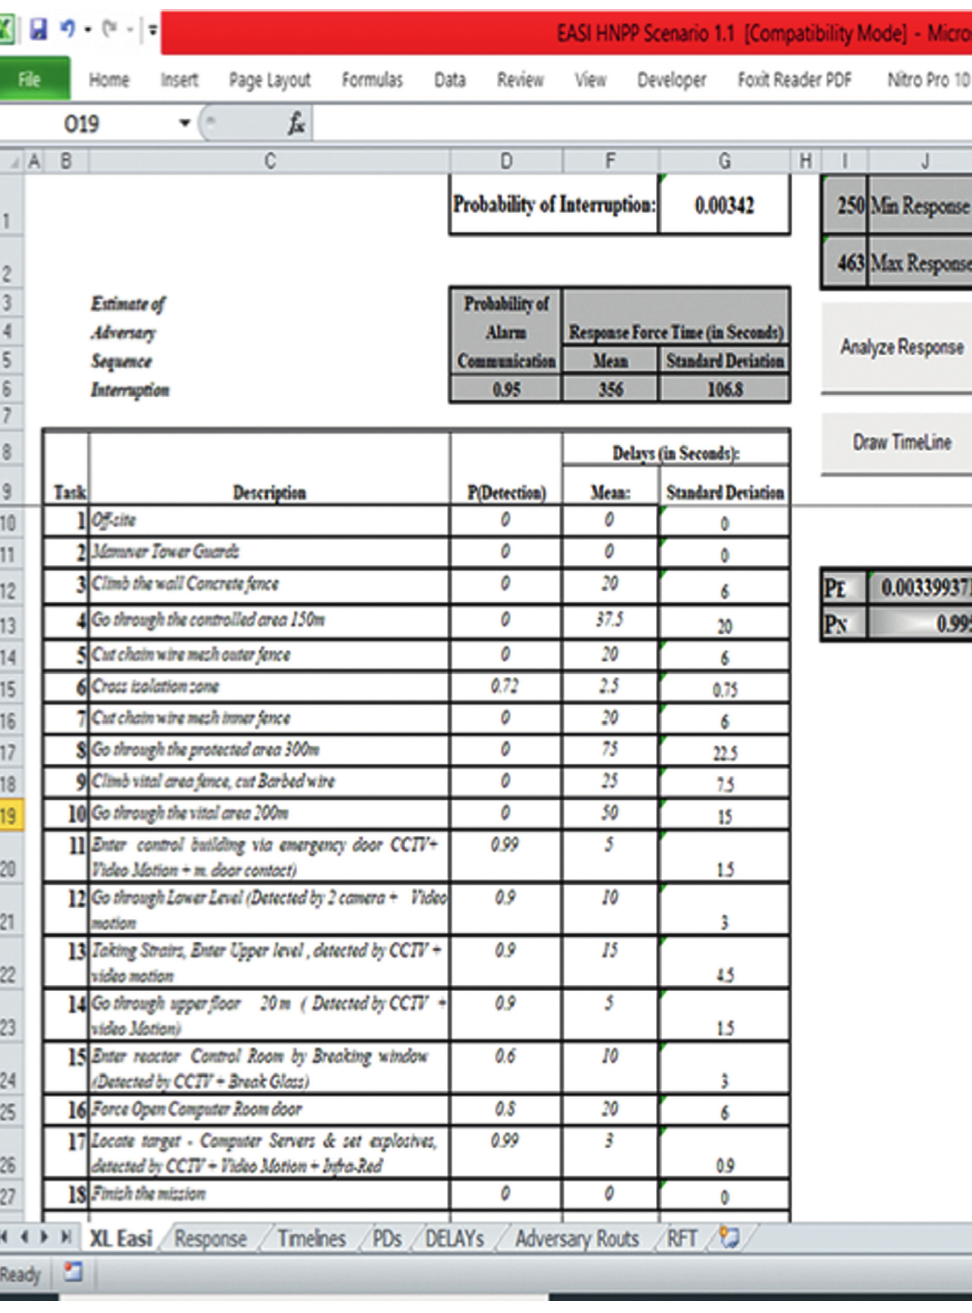
P I and E for scenario 1.1, which results in P E